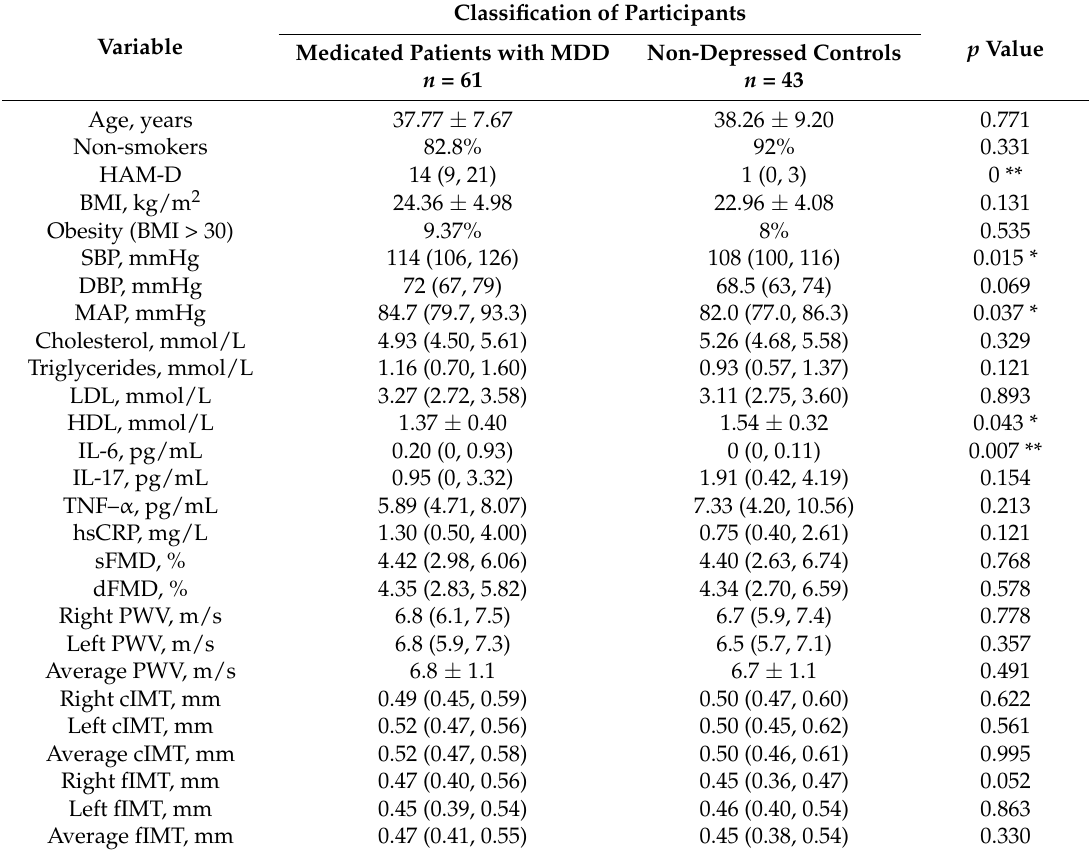
Table 1. Characteristics of medicated patients with major depressive disorder (MDD) and non-depressed